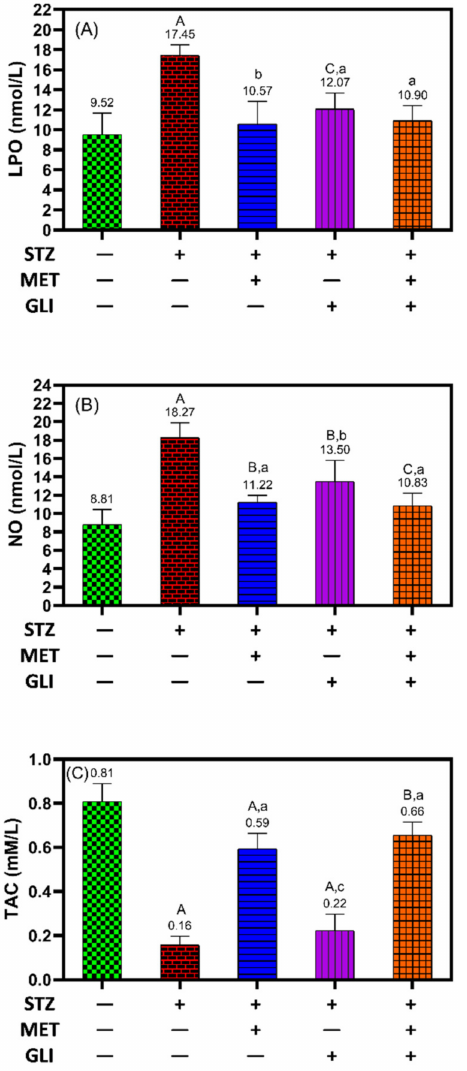
Figure 2. Effects of metformin, glipizide and their combination on the levels of ( A ) lipid peroxidation (LPO), ( B ) nitric oxide (NO) and ( C ) total antioxidant capacity (TAC) in diabetic rats. The data is expressed as the Mean ± SD. A, B, and C notation (in capital letters) indicate the significant difference levels p < 0.001, p < 0.01, and p < 0.05 between studied groups and healthy controls, respectively. While a, b and c notation (in small letters) indicate the significant difference levels p < 0.001, p < 0.01, and p < 0.05 between studied groups and untreated DM groups,